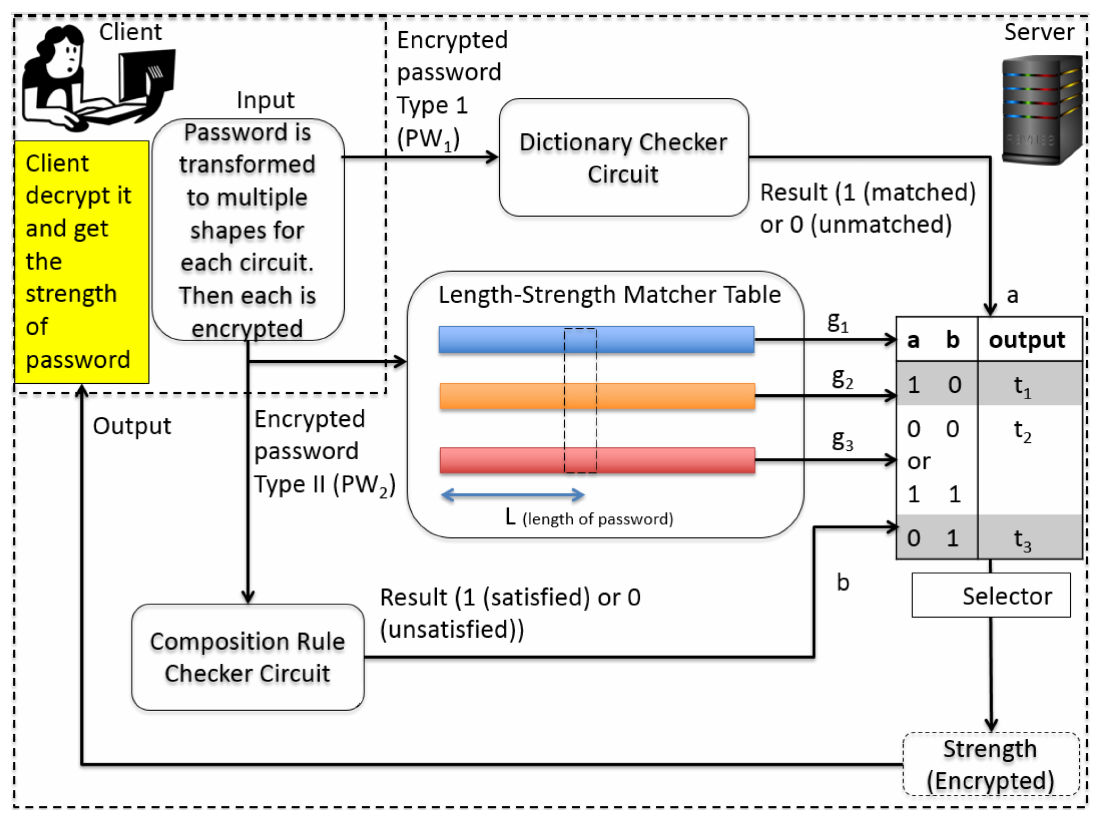
Figure 3. Overview of the proposed